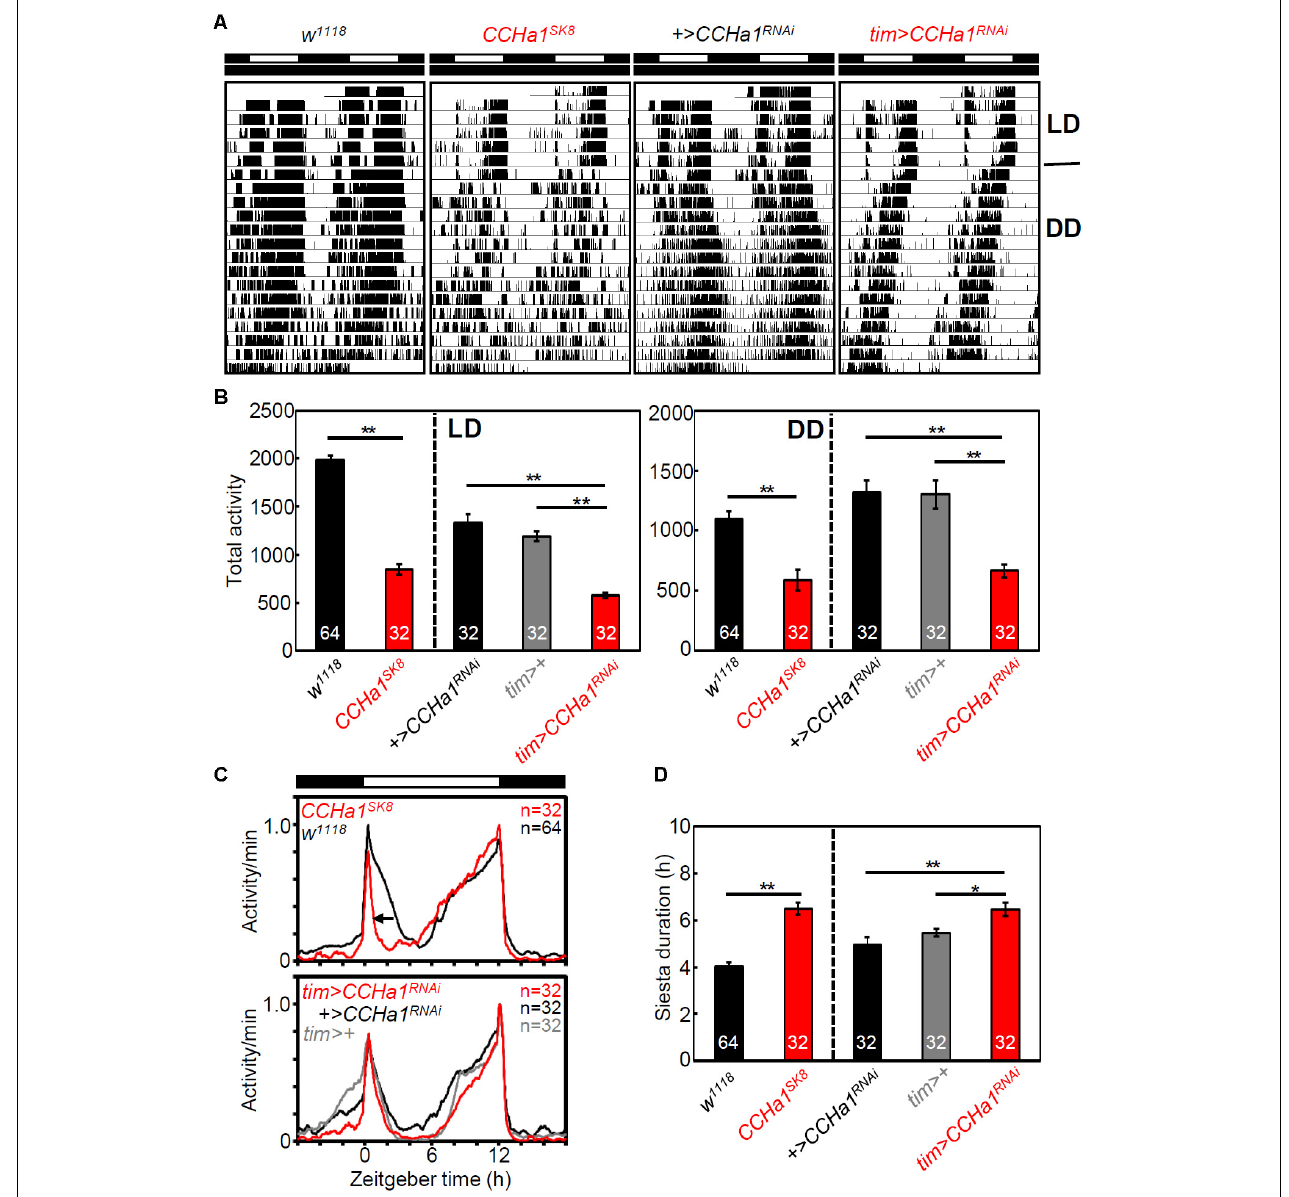
FIGURE 5 | CCHa1 affects morning activity peak and total activity level. (A) Representative actograms of w control, CCHa1 mutant ( CCHa1 SK8 ), UAS control ( + > CCHa1 RNAi ), and CCHa1 knockdown ( tim > CCHa1 RNAi ) strains. (B) Mean total activity levels ( ± SEM) in LD and DD. (C) Average activity profiles of CCHa1 mutants and CCHa1 knockdown flies. The daily average activity for each strain was calculated from the last 3 days of LD. All activity profiles were normalized to 1. (D) Mean siesta durations ( ± SEM) of CCHa1 mutants and CCHa1 knockdown flies. Numbers in the columns indicate the number of flies. One-way ANOVA with Tukey’s multiple comparison test after the Kolmogorov–Smirnov test; ∗ p < 0.05, ∗∗ p <